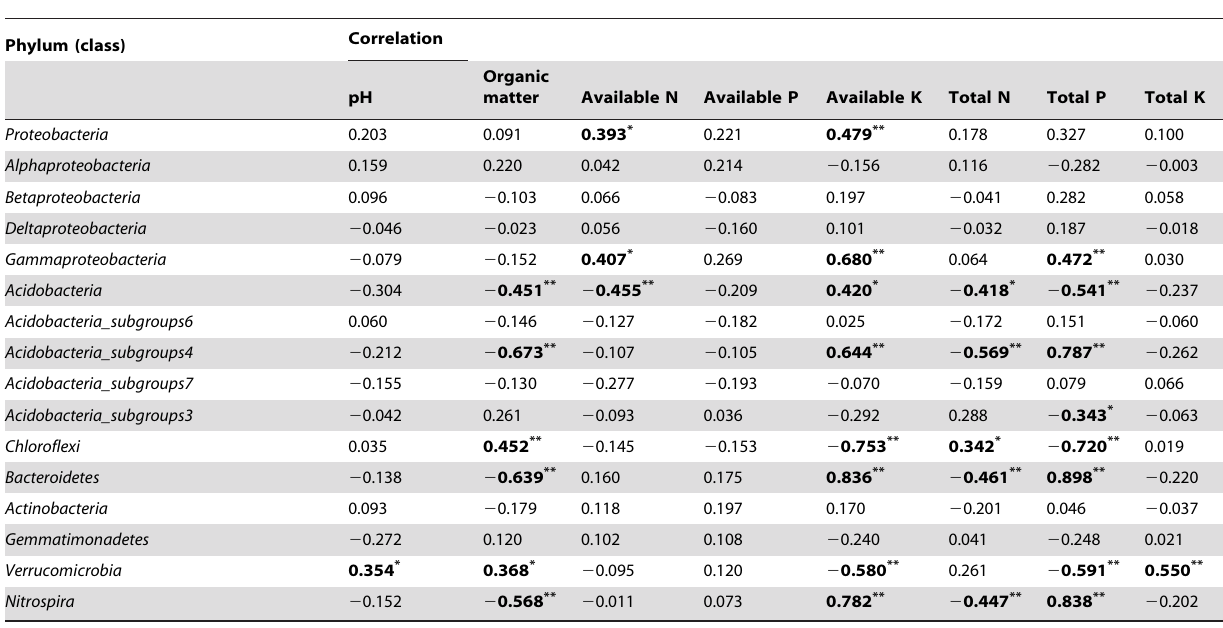
Table 5. Pearson’s correlation coefficient between soil characteristics and abundant phyla (classes).